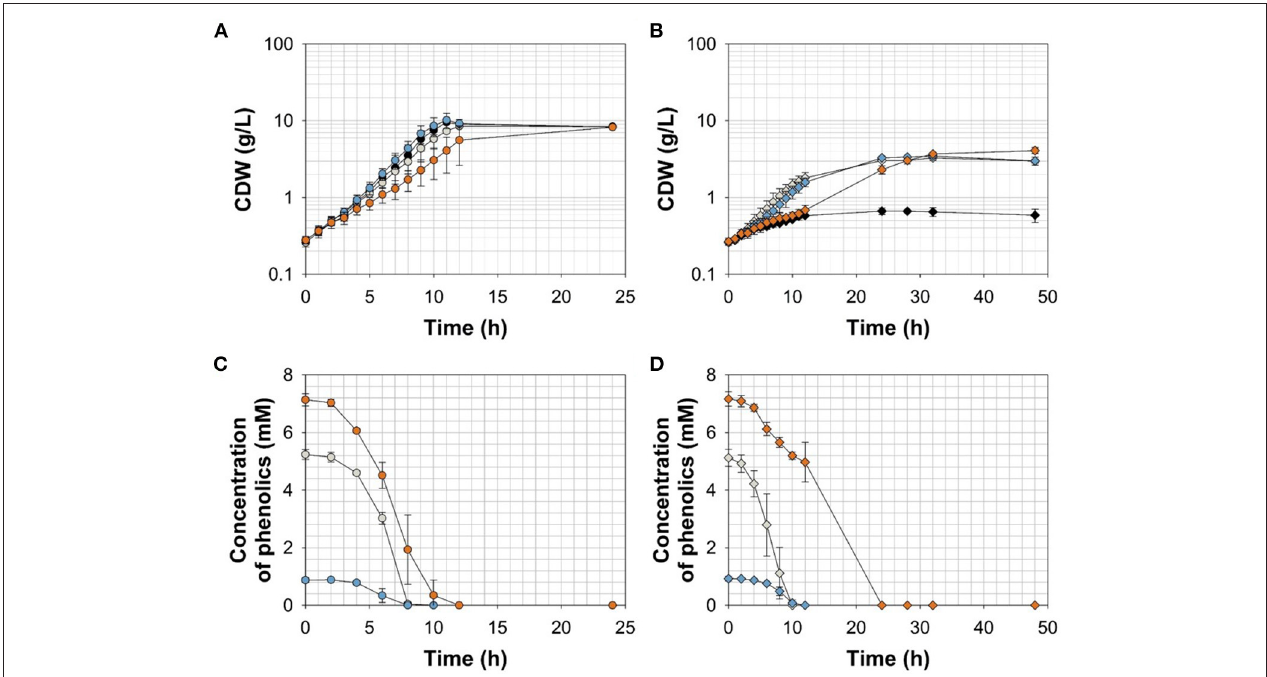
FIGURE 4 | (A,B) Growth and (C,D) effector molecule consumption of C. glutamicum wild type (circles) and C. glutamicum 1 P aceE :: vanR -P vanABK * (diamonds) in shaking flasks with CGXII minimal medium and 20g glucose L − 1 without (black) and with ferulic acid (gray), vanillin (blue), or vanillic acid (orange). Error bars represent standard deviation of cultivations of at least three biological